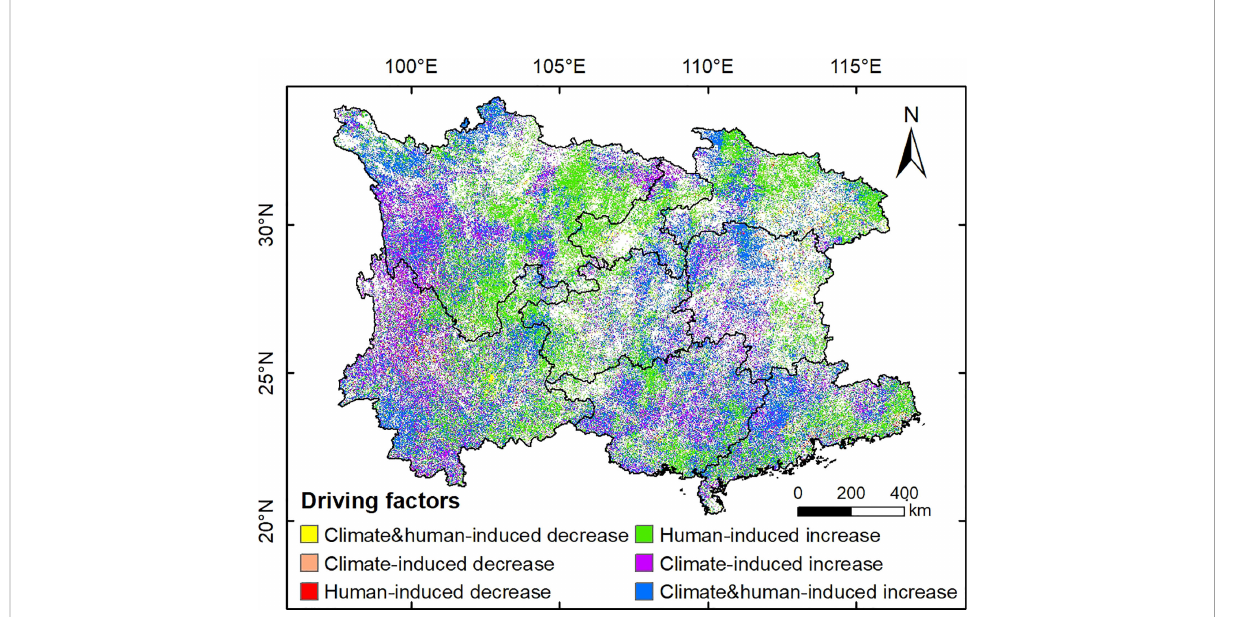
FIGURE 4 Spatial distribution of driving factors for vegetation variations in the regions with signi fi cant NDVI change ( P < 0.05) in southern